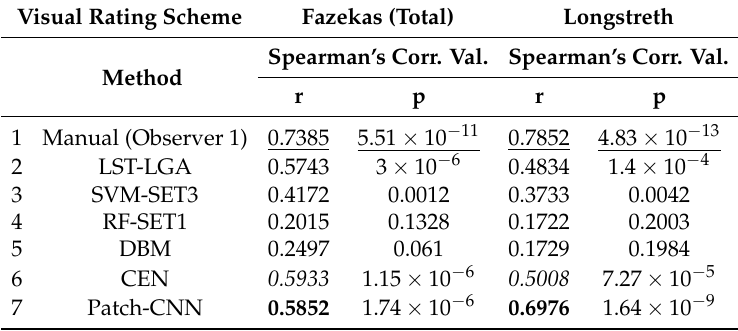
Table 7. Non-parametric correlation using Spearman’s correlation coefficient between WMH volume and Fazekas and Longstreth visual ratings. High r value with low p value are better. Underlined values are correlation values for manual WMH measurement. Whereas, values in bold and italic indicate the best and second-best schemes in this